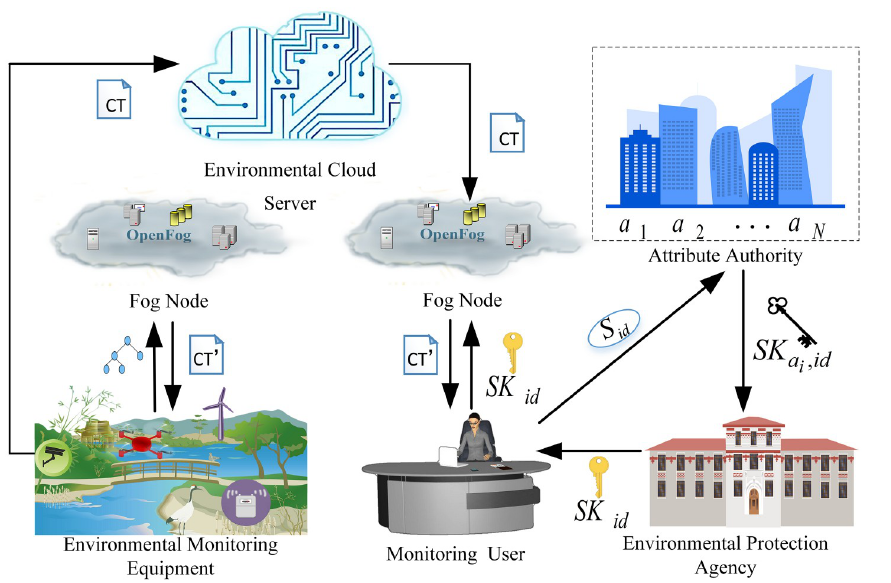
Fig 2. System model. (The source of the components of Fig 2 is described in the Supporting